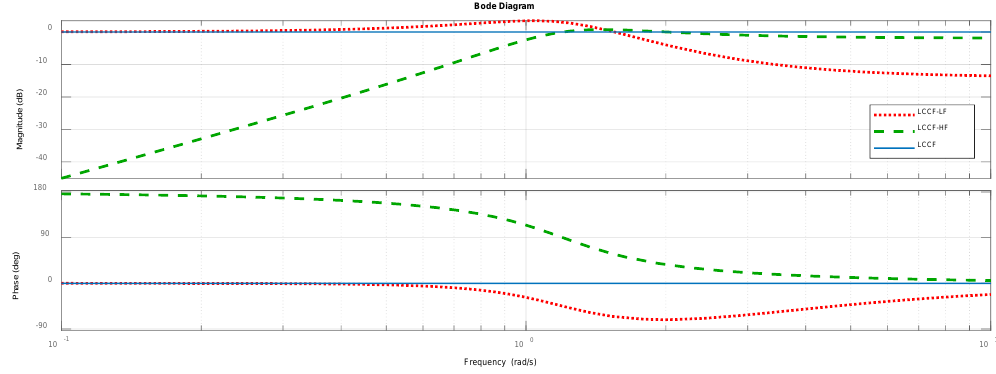
Figure 7. Bode diagram (amplitude and phase) for cascaded complementary filter.